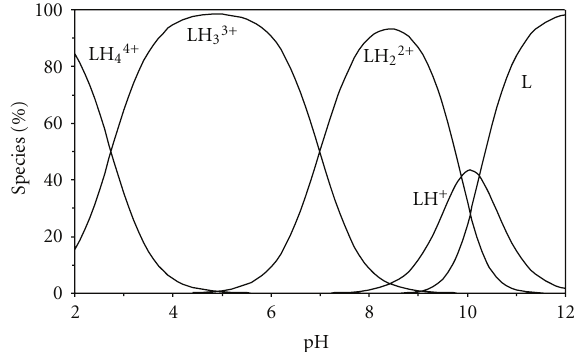
Figure 1: Concentration distribution of various species as a func- tion of pH in the BAPP system (1.25mM of BAPP).